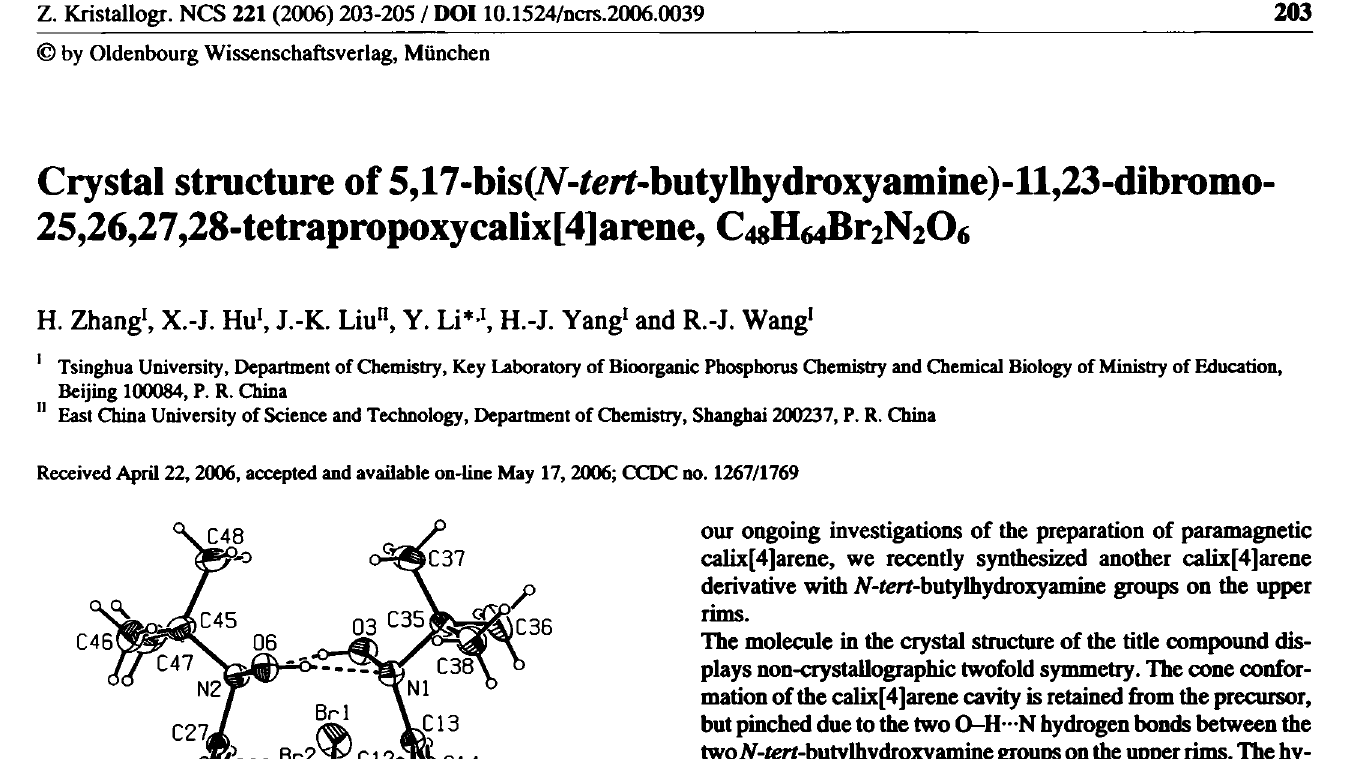
Table 1. Data collection and handling.